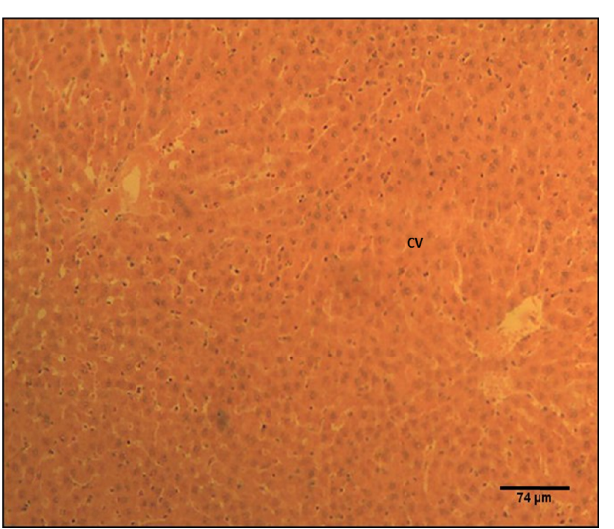
Different superscripts across a row indicates significant differences between the means (